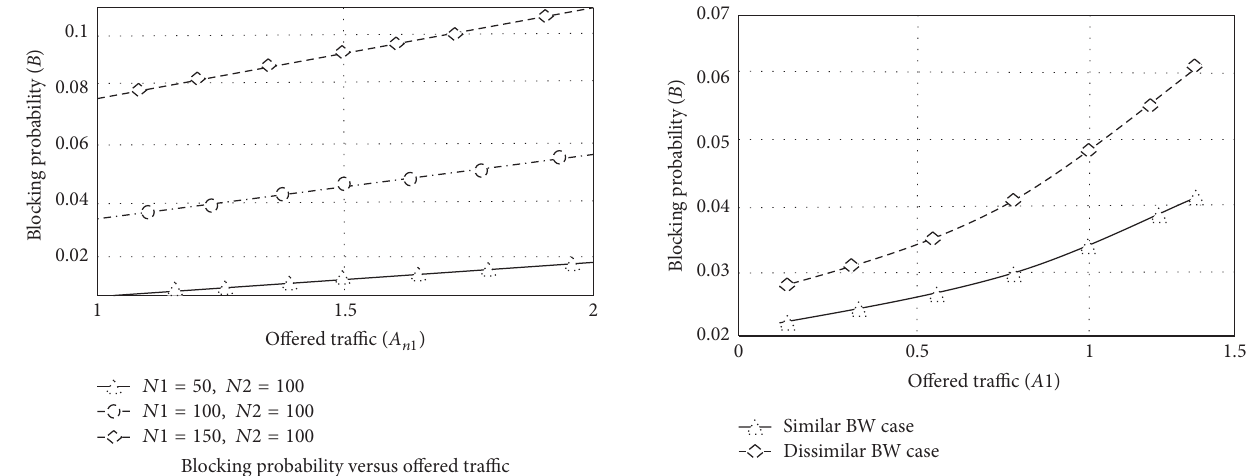
Figure 3: Impact of bandwidth on the blocking probability against the offered traffic (A1).